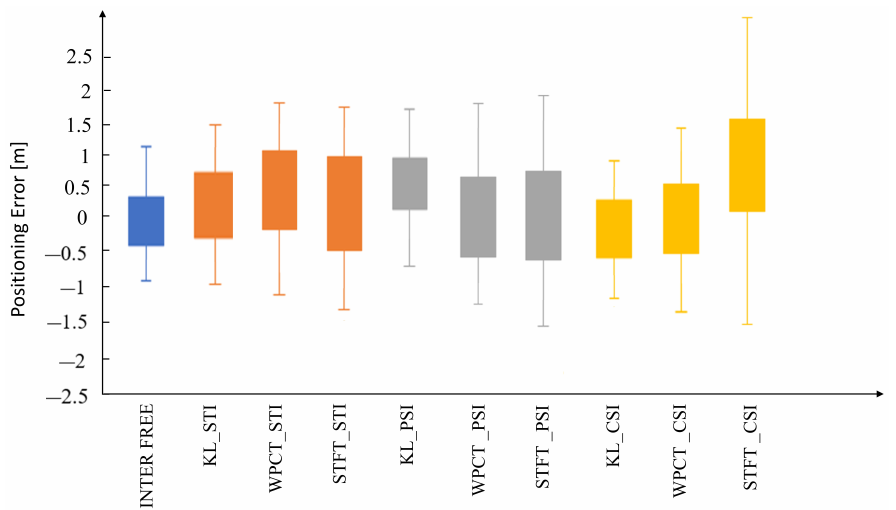
Figure 14. Comparison of positioning accuracy of different algorithms in three jamming scenarios.